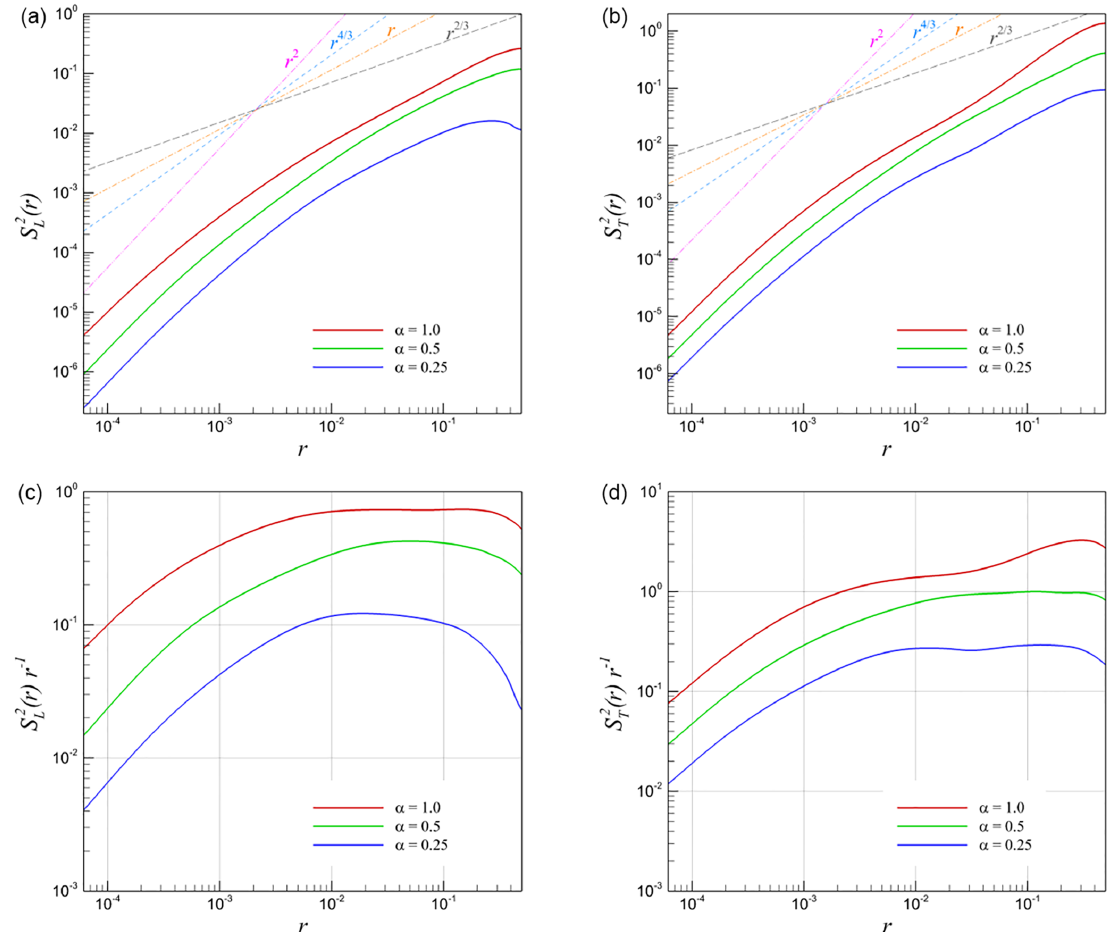
Figure 22. Second-order velocity structure functions for 2-D KHI turbulence. (a) Longitudinal structure function ( u (cid:107) r ), (b) transverse structure function ( u ⊥ r ), (c) compensated form of the longitudinal one, and (d) compensated form of the transverse